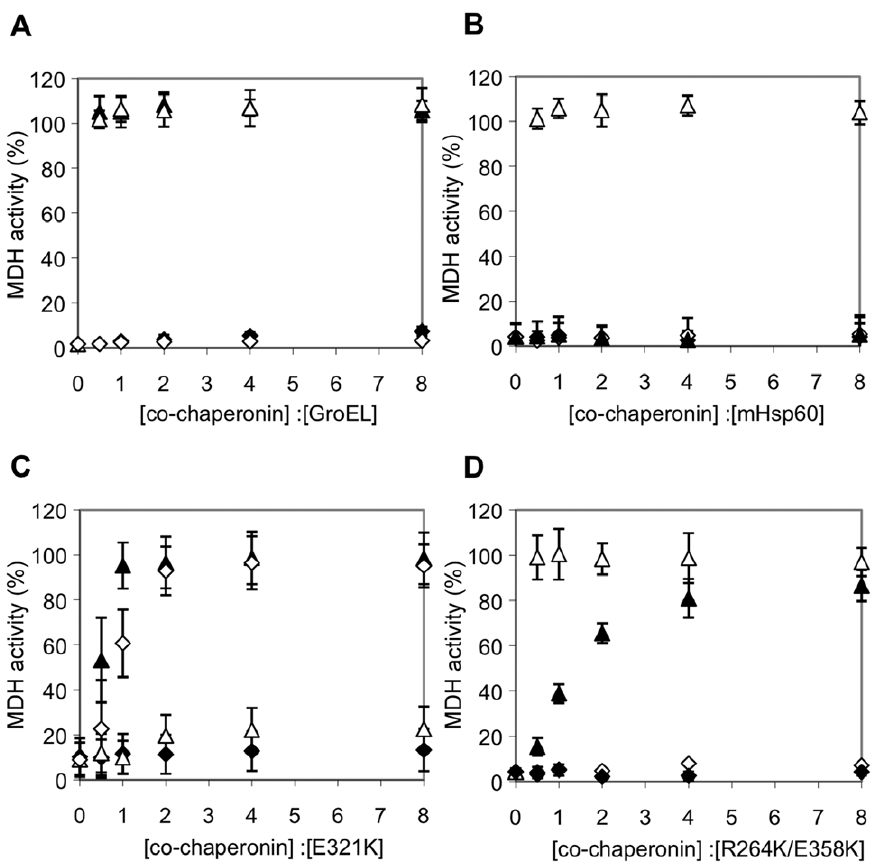
Figure 5. Refolding activity in the presence of increasing concentrations of wild-type and low-affinity co-chaperonins. Refolding of 0.33 m M HCl-denatured MDH by 10 m M of chaperonin GroEL (A), wild-type mHsp60 (B), E321K mHsp60 (C), R264K/E358K mHsp60 (D), in the presence of increasing concentrations of mHsp10 (white triangles), GroES (black triangles) and the low-affinity mutants: mHsp10_L33A (white diamonds) and GroES_L27A (black diamonds). MDH activity was measured at 340 nm following 120 min incubation at 30 u C in the presence of 1 mM ATP. The 100% reference was determined as the activity of a sample containing the same amount of native MDH.